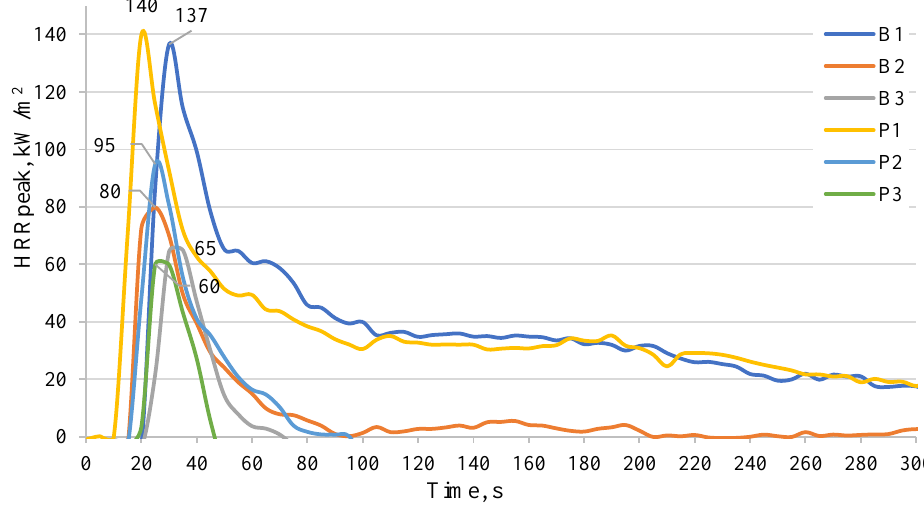
Figure 6. Heat release rate of BAC during the cone calorimeter test. The maximum average heat rate of emission (MAHRE) is best thought of as an ignition- modified rate of heat emission (Figure 7). This parameter can be used in ranking materials according to their ability to support flame spread to nearby objects [29]. The reduction in MAHRE suggests significant alteration in the fire reaction behavior of the BACs with increasing gypsum content. For BACs with BG as a binder, MAHRE reduced from 57 to 24 kW/m 2 or by 58%, while for BAC with PG as a binder, MAHRE reduced from 64 to 23 kW/m 2 or by